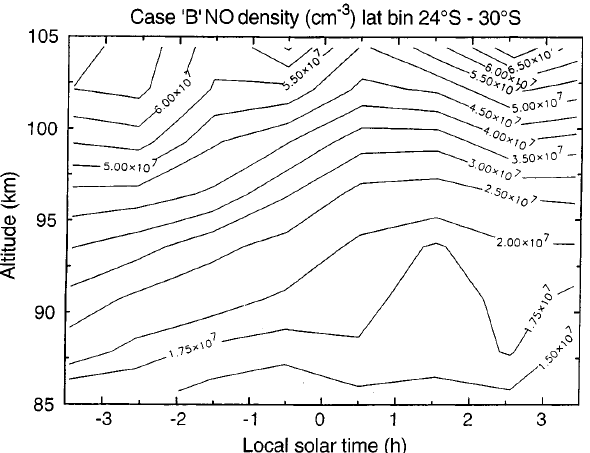
Fig. 6. A contour plot of the nitric oxide densities derived from the WINDII continuum measurements using the case B coe(cid:129)cients for the latitude bin 30 (cid:176) S to 24 (cid:176) S as a function of local solar time and